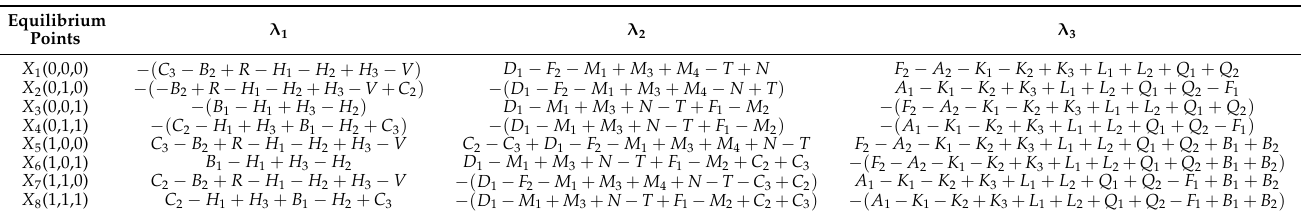
Table 2. Characteristic values in the Jacobian